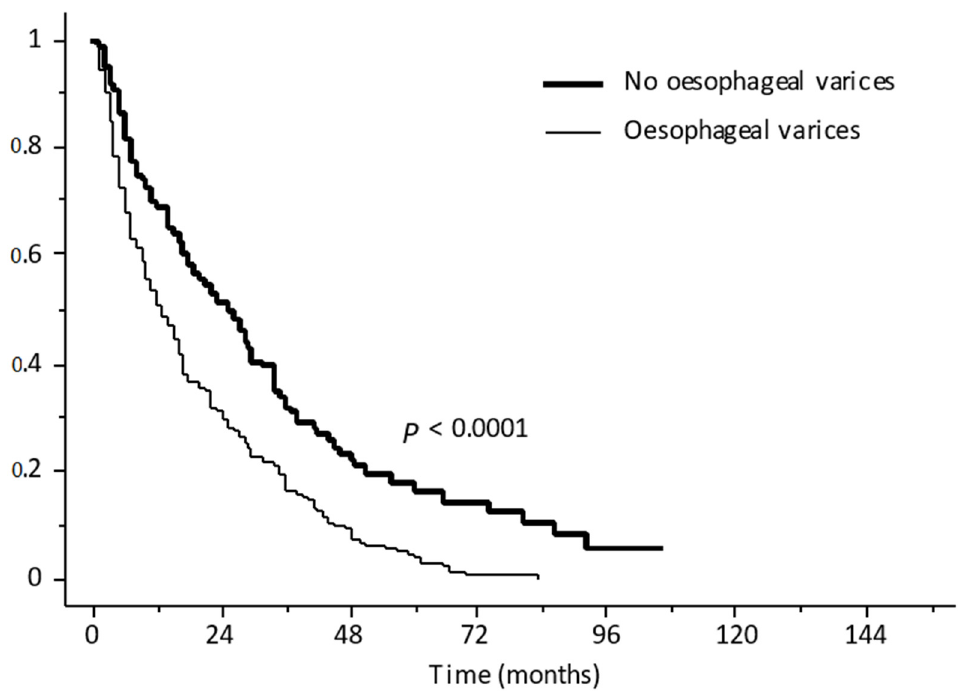
Figure 4. Overall survival of patients with advanced hepatocellular carcinoma, subdivided according to the presence of esophageal varices. Reprinted with permission from ref. [65]. Copyright 2006 American Gastroenterological Association.